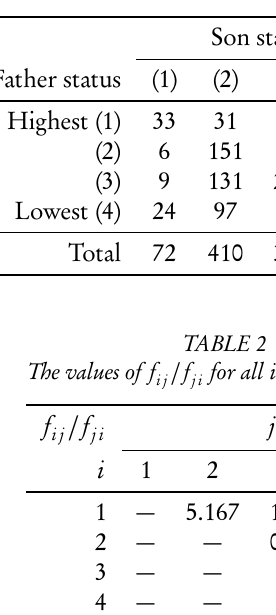
Cross-classification of occupational status categories for father and son dyads in Japan, obtained from Hashimoto (2018, pp. 122–123).